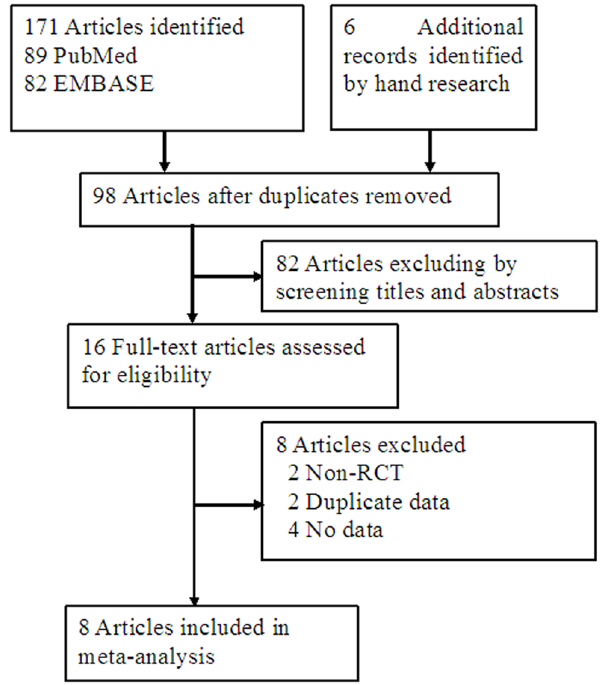
Figure 1. Flow diagram of study selection.